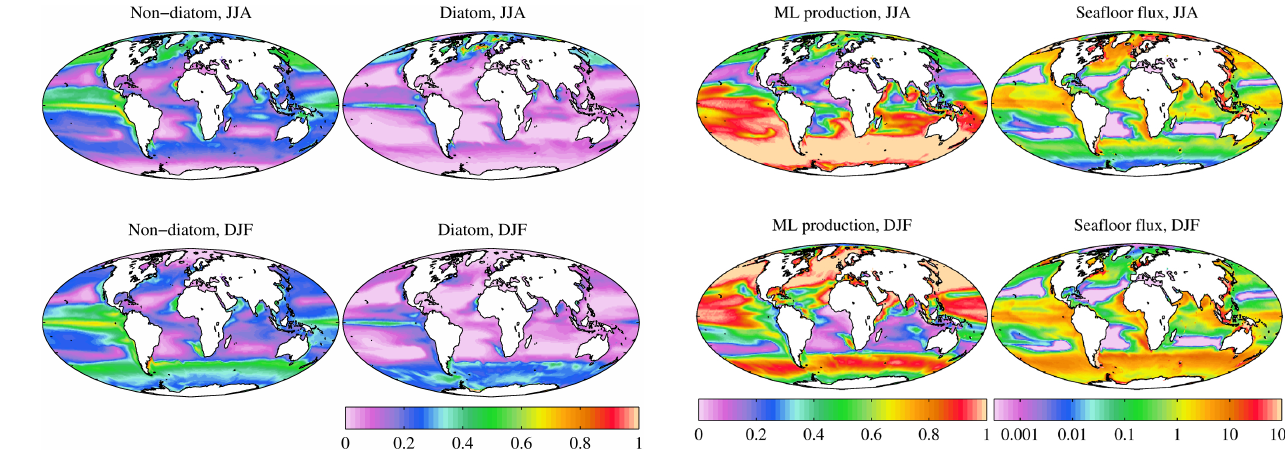
Fig.23. Simulatedsurface non–diatom phytoplankton ( left )and diatomphytoplankton ( right )concentrations fornorth- ern summer (June–July–August; top ) and northern winter (December–January–February; bottom ). Concentrations in mmol m − 3 .